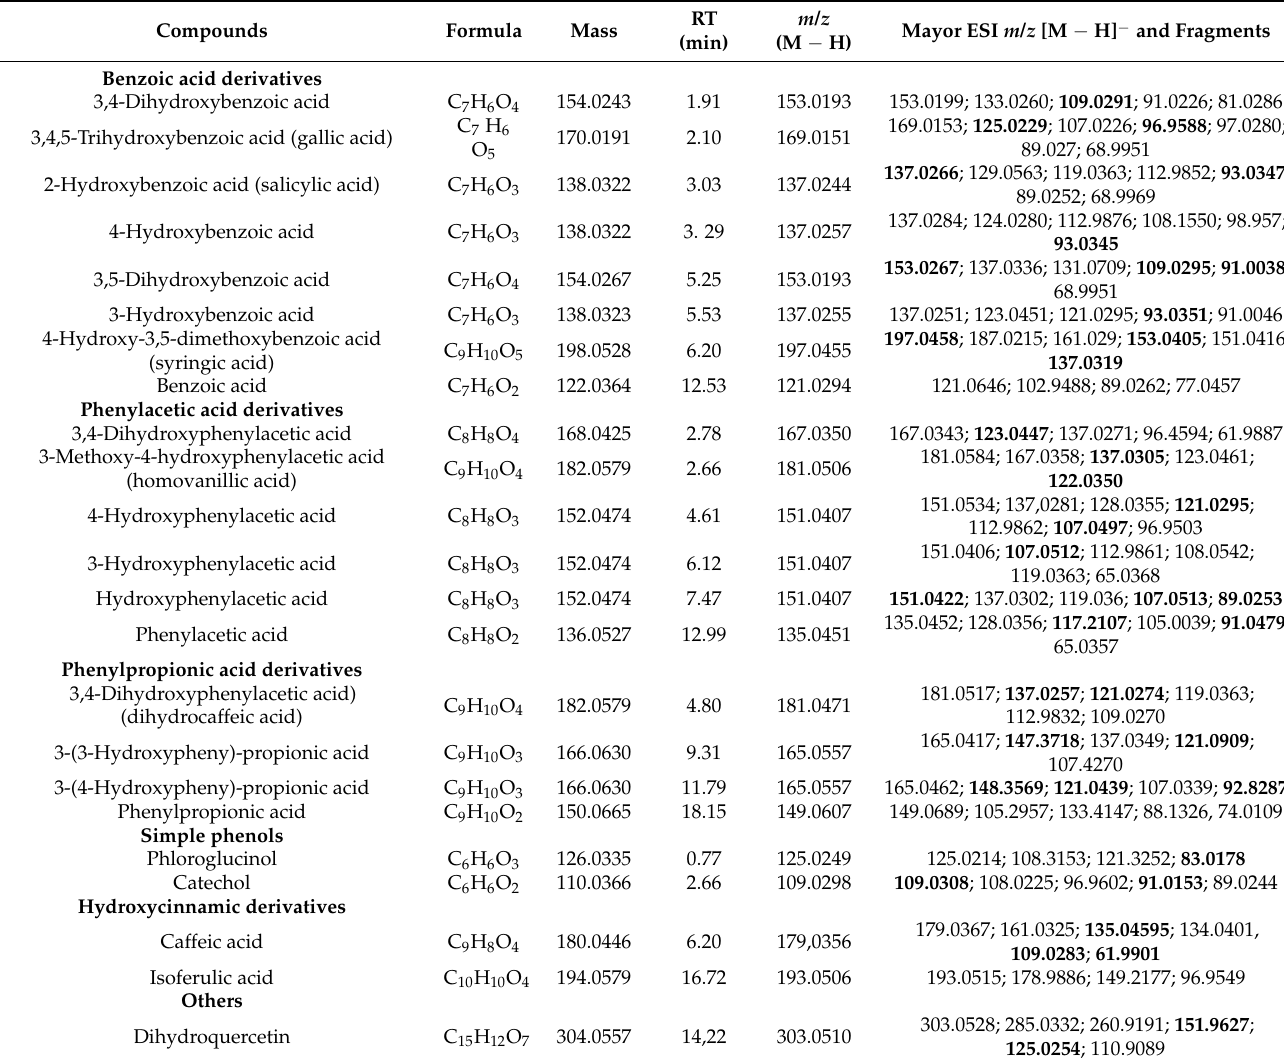
Table 2. Flavonols and phenolic metabolites identification by HPLC-DAD-ESI-QTOF-MS/MS in the fermentation products of HPP-treated onion powder subjected to a dynamic in vitro gastrointestinal digestion and colonic fermentation simulator. Compounds